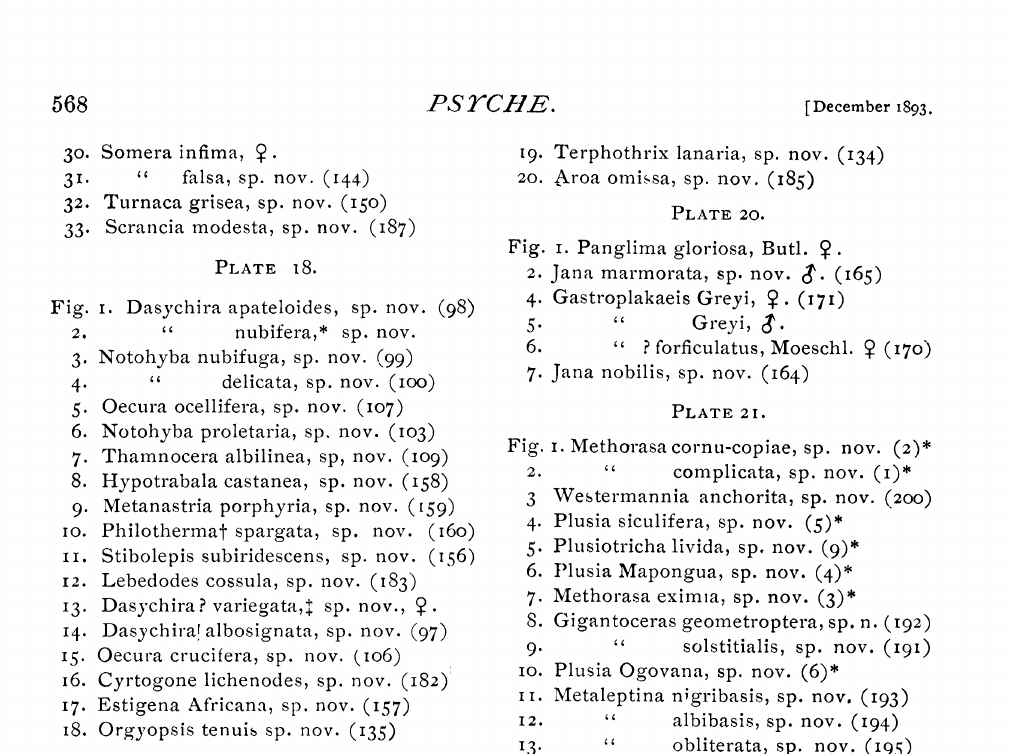
PLATE 20. Fig. I. Panglima gloriosa, Butl.